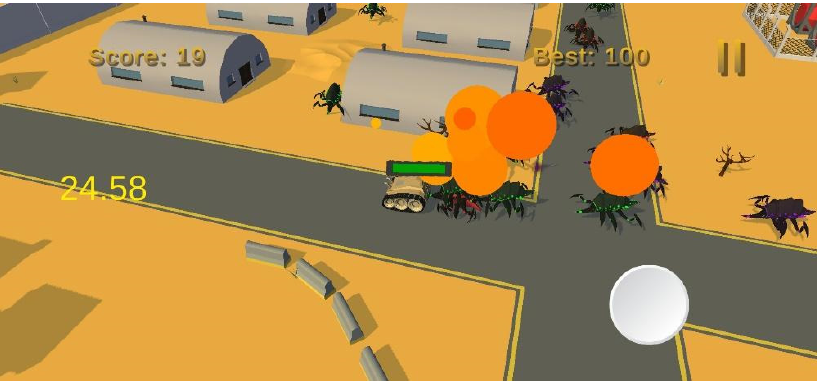
Figure 18. Snapshot after the elimination of 19 enemies in the non-optimized version of the game.